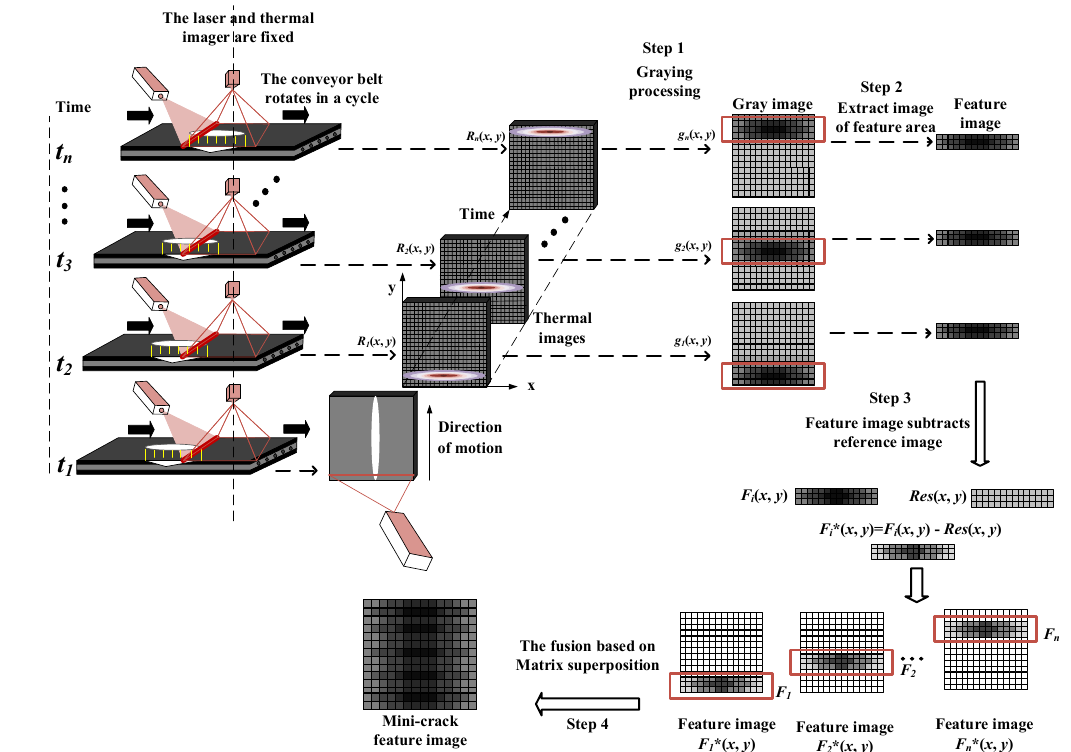
Figure 3. Mini-crack image feature extraction based on laser excited thermography ( F i * ( x , y ) is the new feature image which is obtained by removing the reference image Res ( x , y ) from the feature image F i ( x , y )).